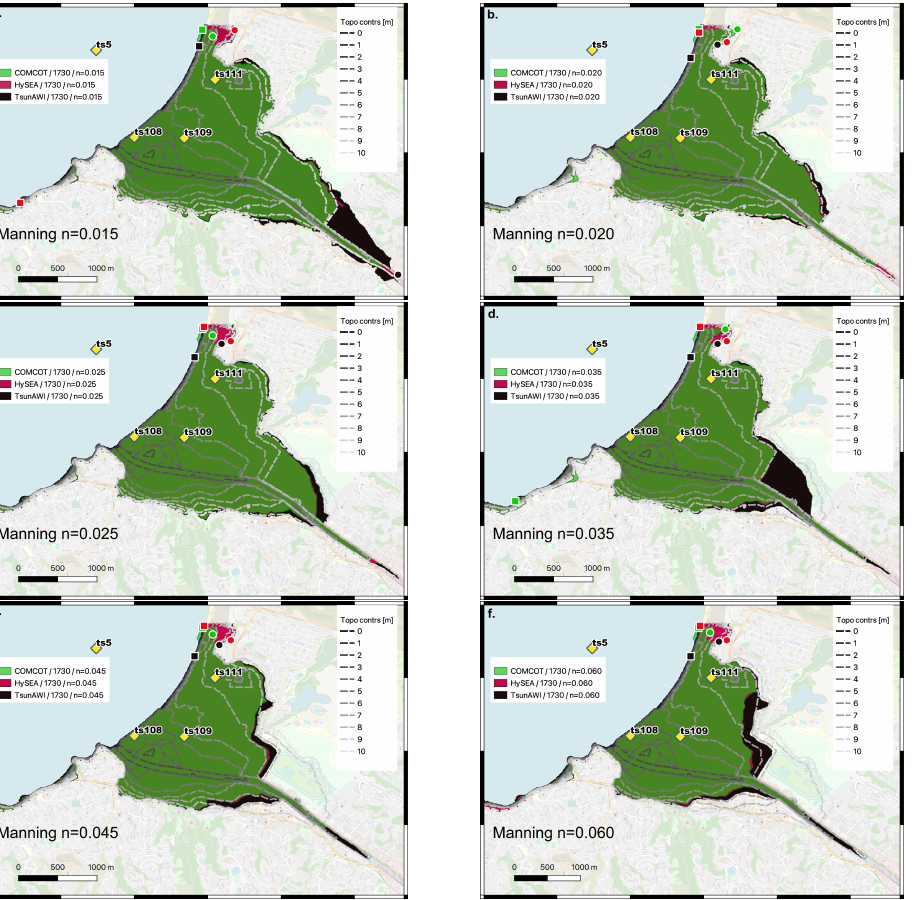
Figure 12. Inundation area in Viña del Mar for all Manning values obtained by the three models for Experiment 1730. ( a ). Manning n -value of 0.015. ( b ). Manning n -value of 0.020. ( c ). Manning n -value of 0.025. ( d ). Manning n -value of 0.030. ( e ). Manning n -value of 0.045. ( f ). Manning n -value of 0.060. Yellow diamonds are virtual tide (ts5) and inland gauges, squares (red, black, green) show positions of the maximum inundation, while circles (red, black, green) show positions of the maximum run-up. Basemap: © OpenStreetMap